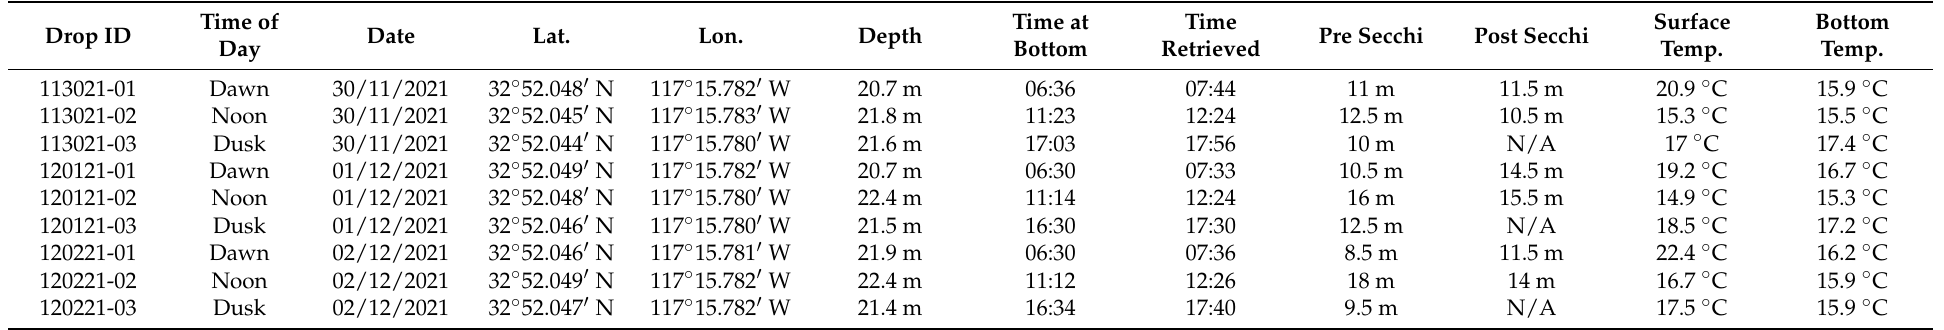
Table 1. Field deployment details, with date, latitude (Lat.), longitude (Lon.), bottom depth (in meters), time at which the camera reached the bottom and was retrieved, water visibility (in meters) before a deployment (pre-Secchi) and after a deployment (post-Secchi), and surface and bottom temperatures (temp.; in degrees